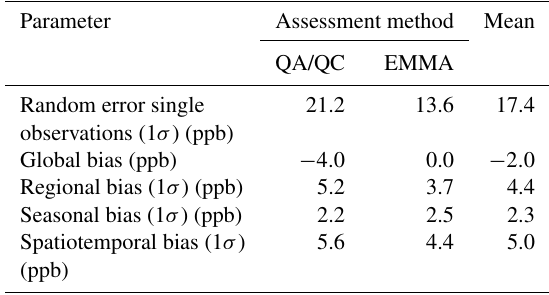
Table 8. Validation summary for data product XCH4_EMMA (ver- sion